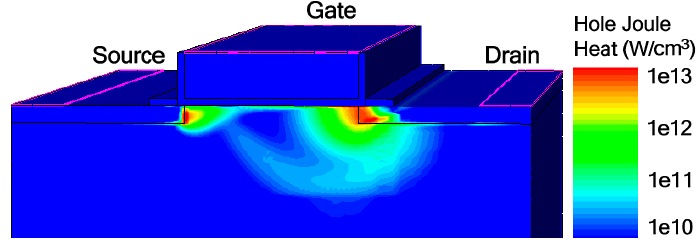
Figure 6. Contour plot of hole Joule heat simulated at 90 ns under a TLP current density of 0.5 mA/ μ m.